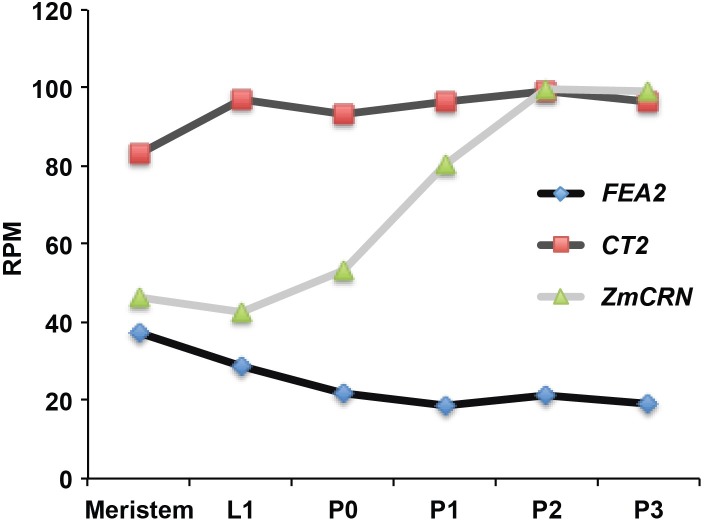
Expression of FEA2, CT2 and ZmCRN in different domains of the SAM.Expression values were extracted from the maize shoot apex RNAseq Atlas from the Timmermans Lab (available at https://maizegdb.org/, ). The samples are from B73 and different domains are captured by laser microdissection (LCM). L1 = epidermal (L1) layer of SAM, p=primordium number), RPM = reads per million.